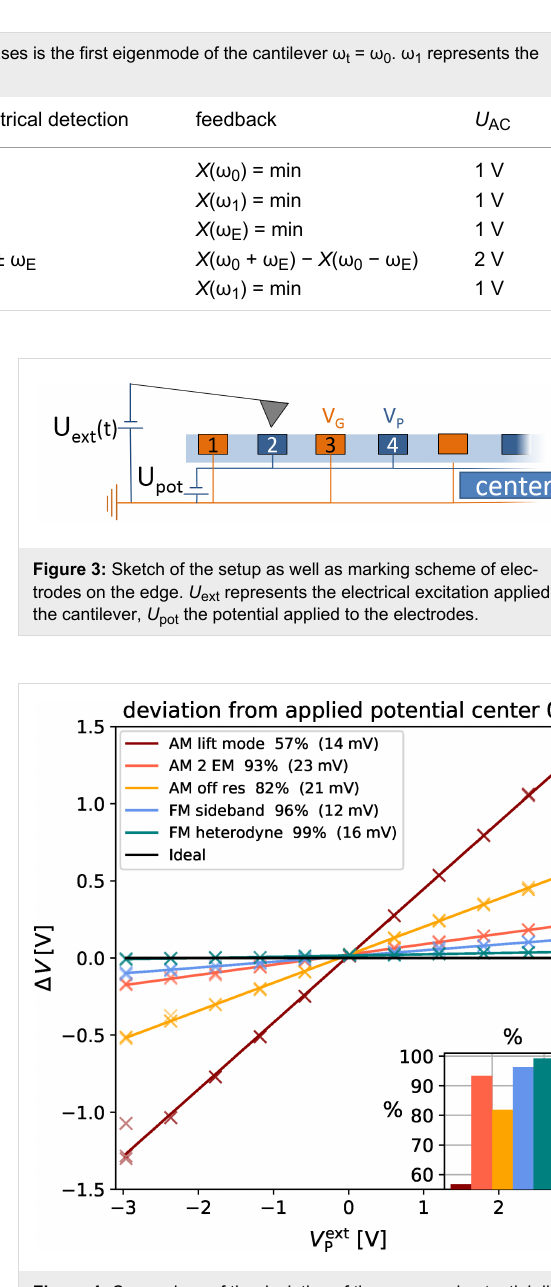
Figure S5 in Supporting Information File 1. Displayed in black is an ideal curve together with the potentials measured with the three AM-KPFM methods (red, orange and yellow) and the two FM-KPFM methods (blue and turquoise). Any positive slope in these graphs indicates that the measured potential was lower than . To which fraction the external voltage was